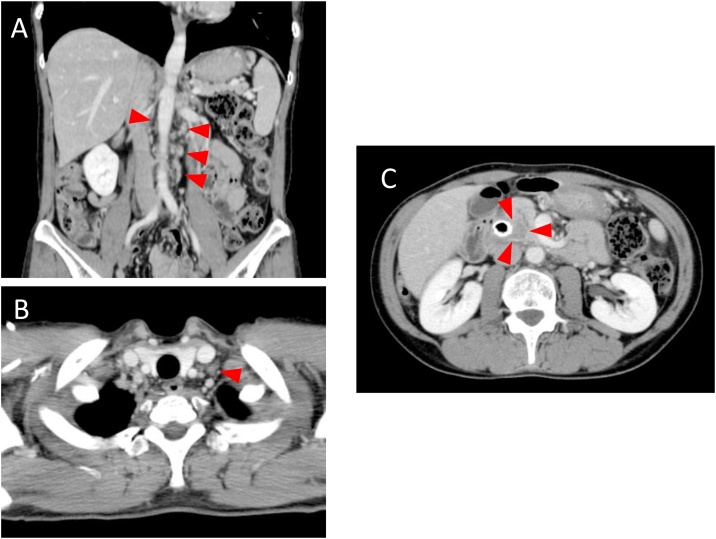
Computed tomography (CT) scan after FOLFIRINOX (combination of 5-fluorouracil, leucovorin, irinotecan, and oxaliplatin) treatment showing only tiny appearances of distant lymph nodes. A: para-aortic lymph nodes (red arrow heads); B: left supraclavicular lymph node (a red arrow head); C: primary lesion (red arrow heads).